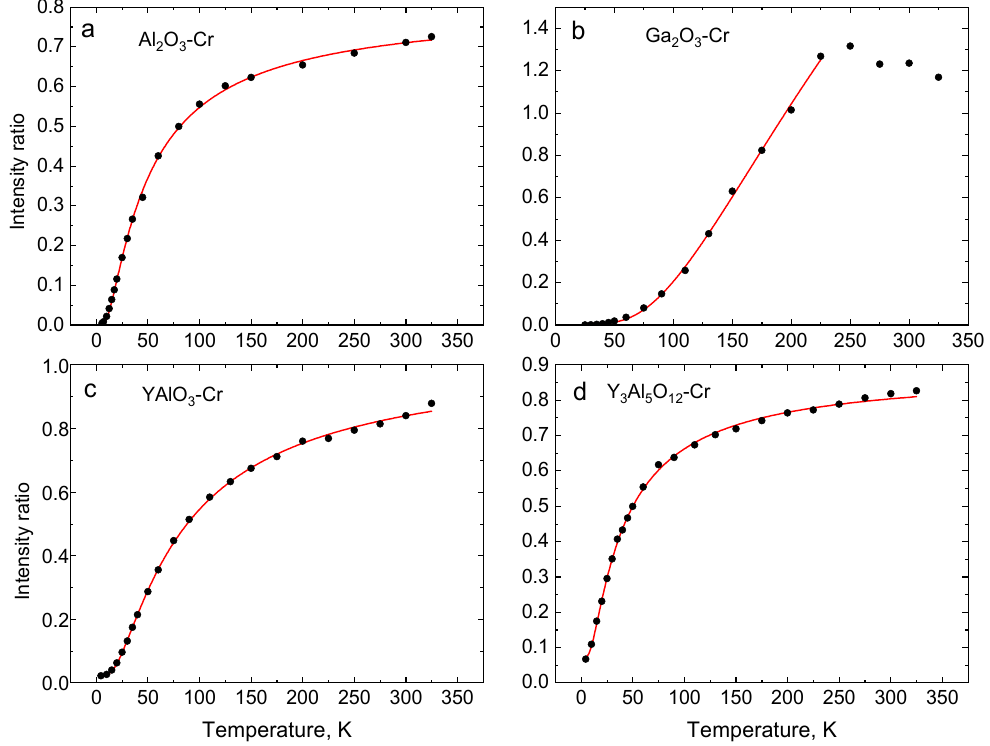
Figure 5. Temperature changes of the luminescence intensity ratio of R-lines ( F = I R 2 / I R 1 ) in Al 2 O 3 -Cr ( a ), Ga 2 O 3 -Cr ( b ), YAlO 3 -Cr, ( c ) and Y 3 Al 5 O 12 -Cr ( d ). The red lines show the best fit of experimental results (black dots) to Equation (1) using the parameters presented in Table 2.